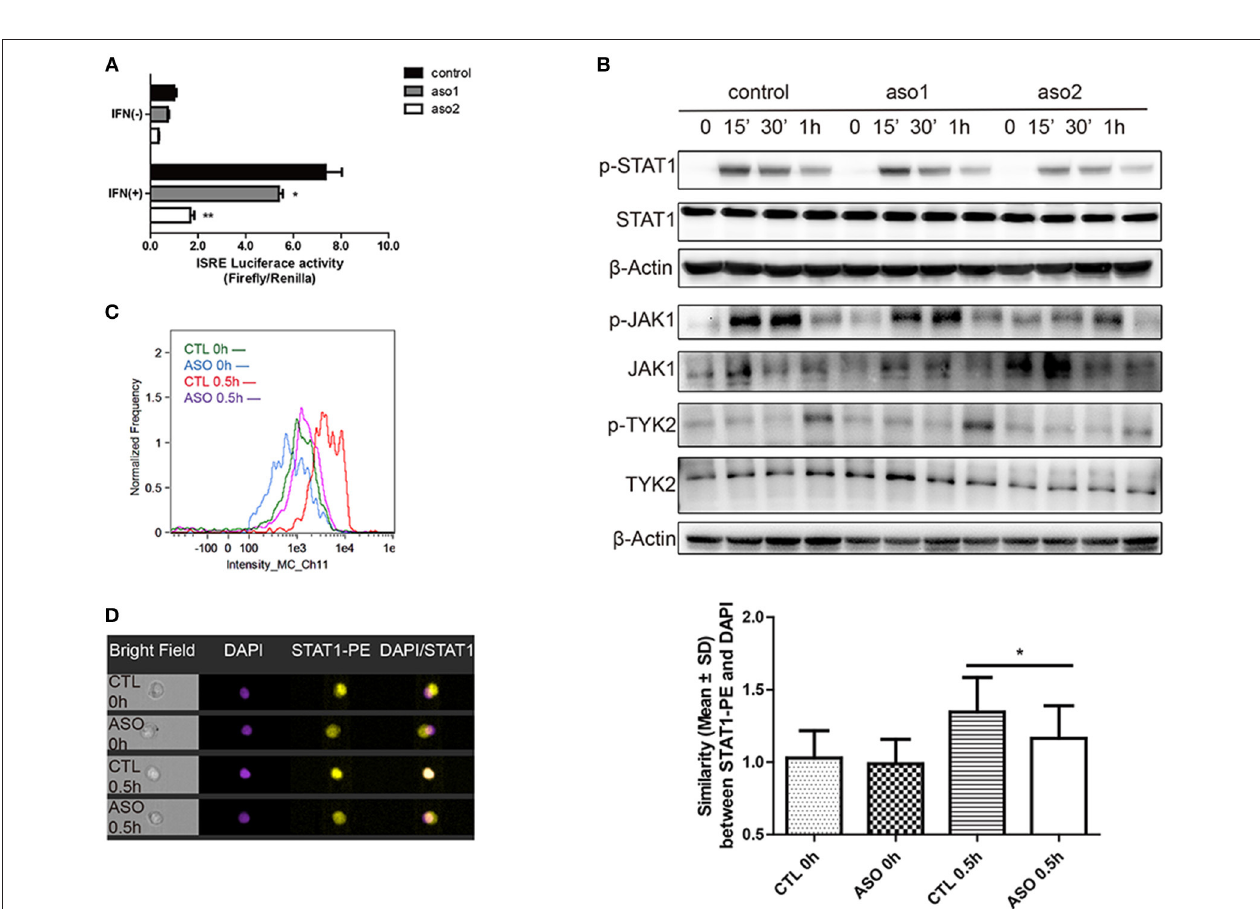
FIGURE 2 | dcas9-KRAB (250 ng) together with sgRNA vectors (250 ng) for 48h, then IFN-I was added. The cells were harvested after 6h of stimulation. The relative expression of IFIT1 and OAS1 was detected with qPCR. (C) HeLa cells were transfected with lncRNA RP11-2B6.2 overexpression (200 ng) or empty pcDNA 3.1( + )-5 ′ -HA vectors (200 ng) for 24h, and dcas9-VP64 (250 ng) together with sgRNAs (250 ng) for 48h, then IFN-I was added. The cells were harvested after 6h of stimulation. The relative expression of IFIT1 and OAS1 was detected with qPCR. HRMCs and HK2 cells were transfected with lncRNA RP11-2B6.2 ASOs or scramble before IFN-I treatment. IFIT1 and OAS1 mRNA levels detected by qPCR after 6h were shown in (D) . CXCL10 mRNA levels were detected by qPCR after 6h of stimulation, and CXCL10 protein levels in the supernatants were detected by ELISA after 12h of stimulation, data are shown in (E) . The group with the negative control or empty vector and without the addition of IFN-I, was set to “1.” * P < 0.05, ** P < 0.01, *** P < 0.001.